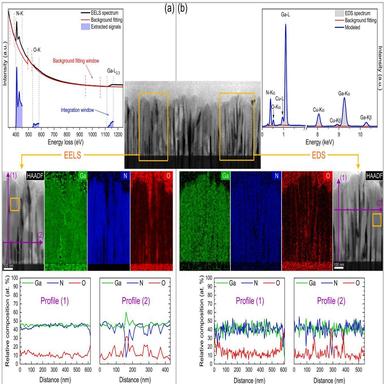
(a) STEM-EELS and STEM-EDX spectrum image datasets recorded across GaN NWs (using drift correction). The integrated spectra over 100 × 100 nm2 areas (indicated on the HAADF images below by yellow rectangles), and the extracted/modelled signals used for quantifications are shown on the top. The quantification results in the square areas are reported in Table 2. The Ga, N, and O 2D concentration maps obtained after quantifications as well as the corresponding HAADF images of the analysed regions are displayed